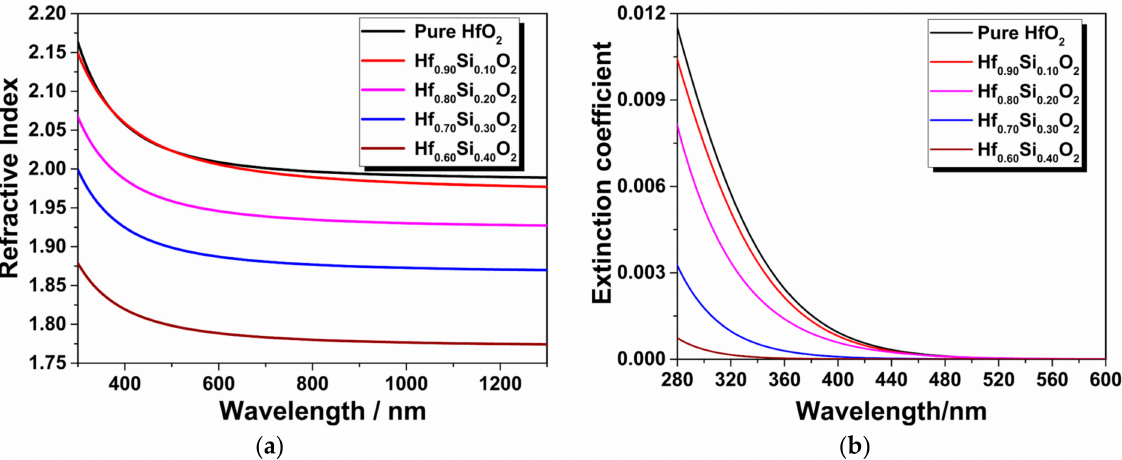
Figure 2. Refractive index ( a ) and extinction coefficient ( b ) dispersion curves of the Hf 1 − x Si x O 2 nanocomposite with different SiO 2 contents.